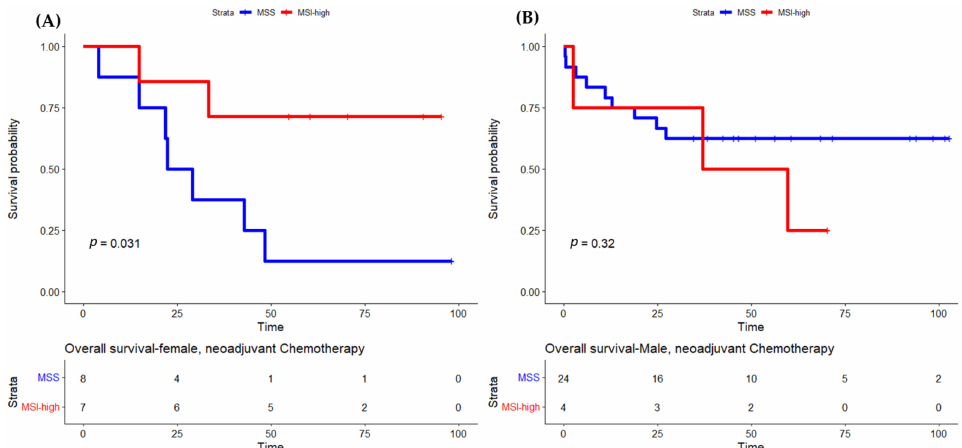
Figure 4. Overall survival by MSI status in females ( A ) and males ( B ) submitted to neoadjuvant chemotherapy. MSI, microsatellite instability; MSS, microsatellite